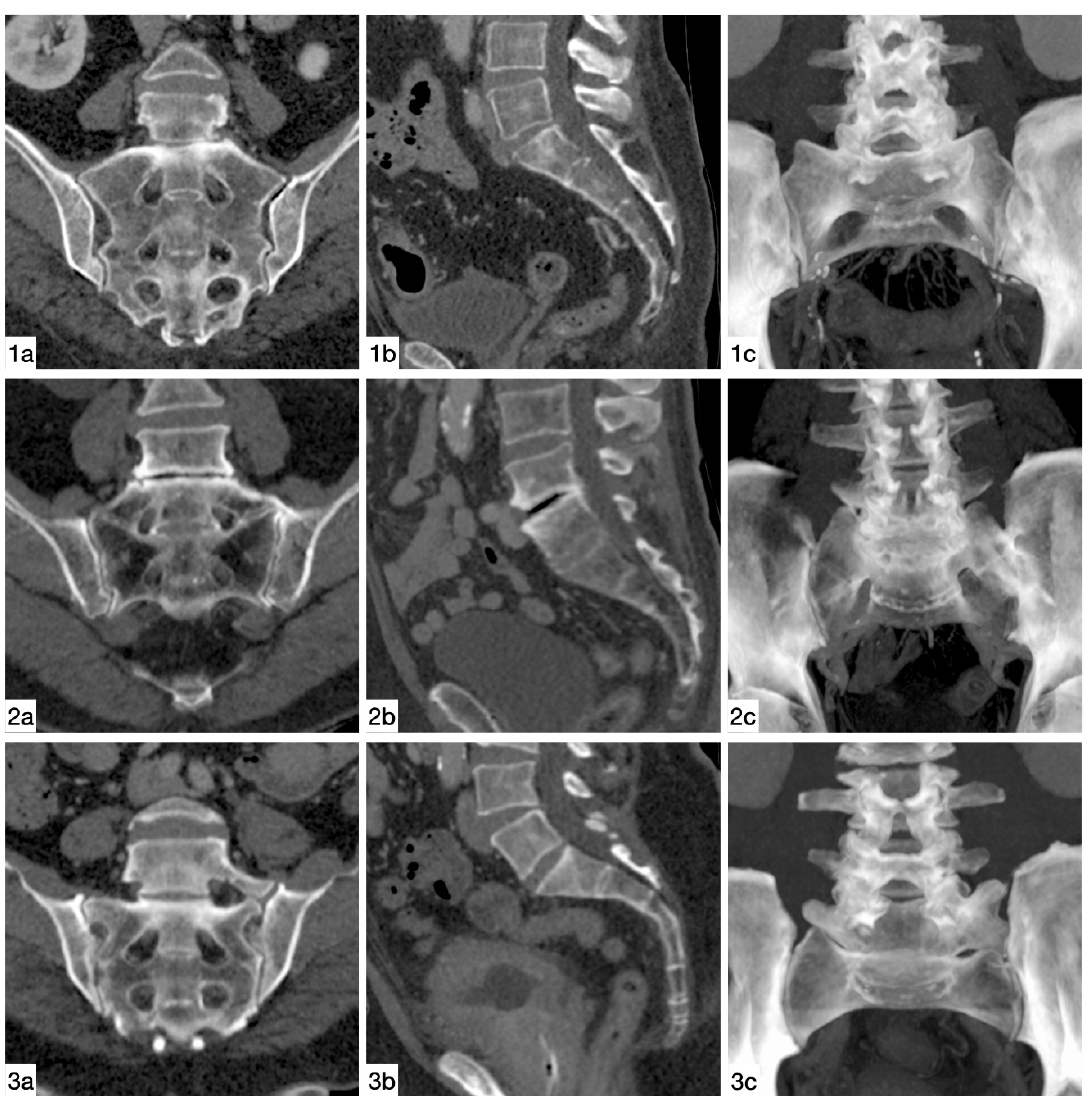
Figure 5. Imaging examples. Normal anatomy: oblique coronal, parallel to S2 ( 1a ) and sagittal ( 1b ) reconstructions, as well as 34 mm maximum intensity projection ( 1c ); 4 LV: oblique coronal, parallel to S2 ( 2a ), and sagittal ( 2b ) reconstructions, as well as 34 mm maximum intensity projection ( 2c ); 6 LV: oblique coronal, parallel to S2 ( 3a ), and sagittal ( 3b ) reconstructions, as well as 34 mm maximum intensity projection ( 3c ).